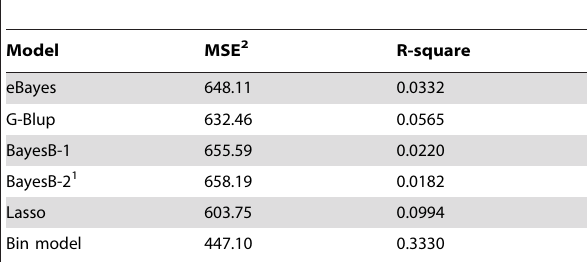
Table 1. Mean squared error (MSE) and R-square values obtained from the 10-fold cross validation analysis for the beef carcass trait using five competing models and the proposed bin